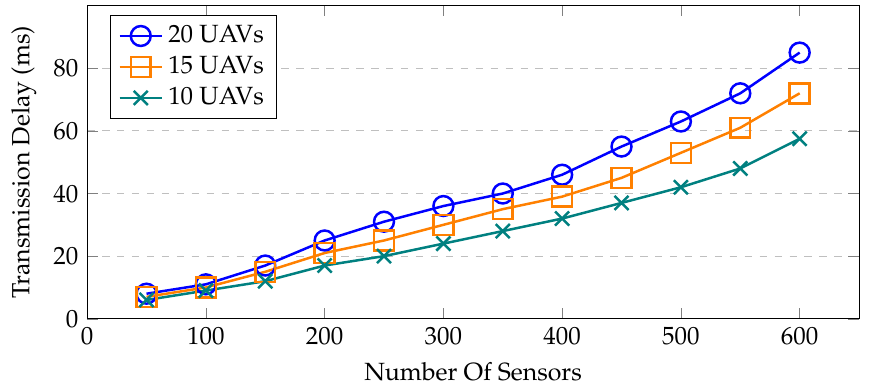
Figure 11. Transmission delay between sensors and